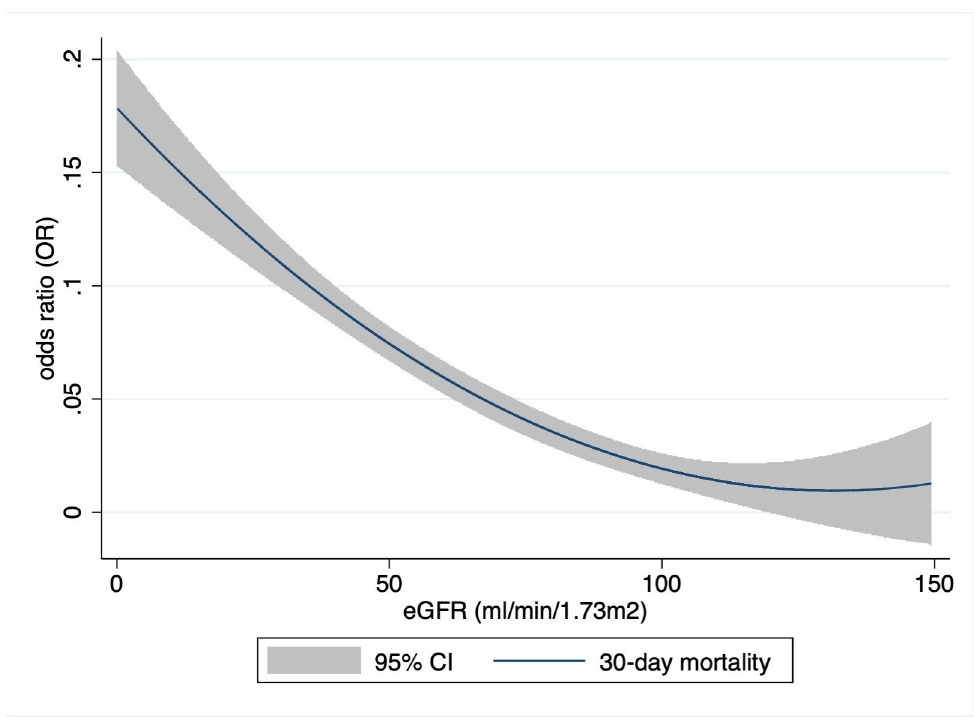
Fig 1. Hazard ratio of 30-day mortality as a function of eGFR. (x-axis, eGFR (ml/min/1.73m 2 ), y-axis, odd ratio for 30-day mortality, CI, confidence interval).